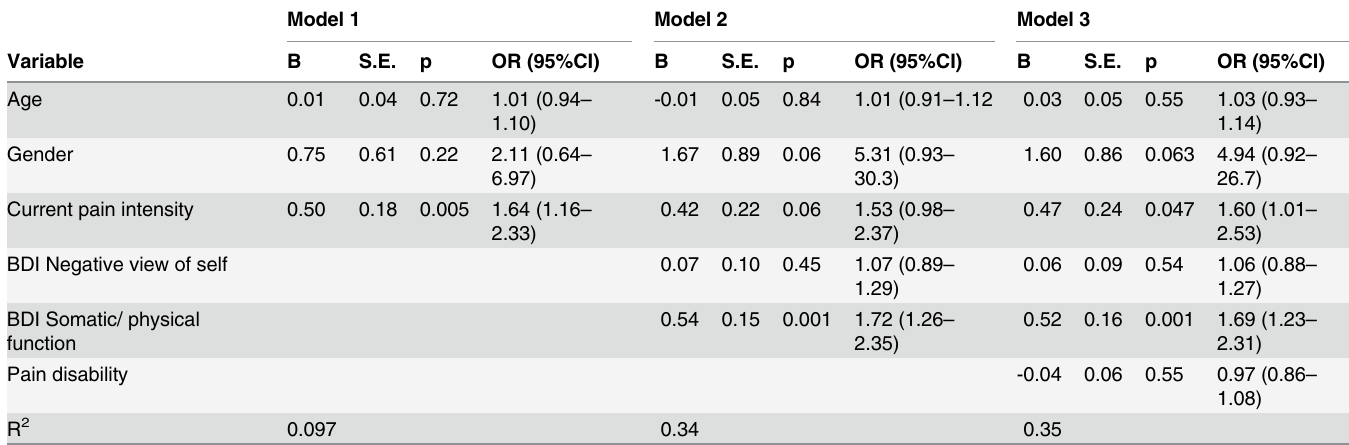
Table 4. Logistic regression analysis with current Major Depressive Disorder (MDD) as dependent variable.